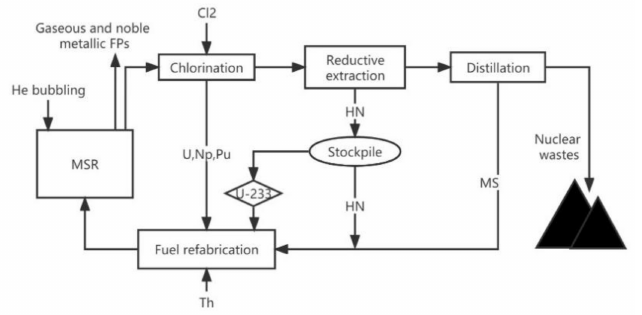
Figure 2. The reprocessing diagram of MSR.